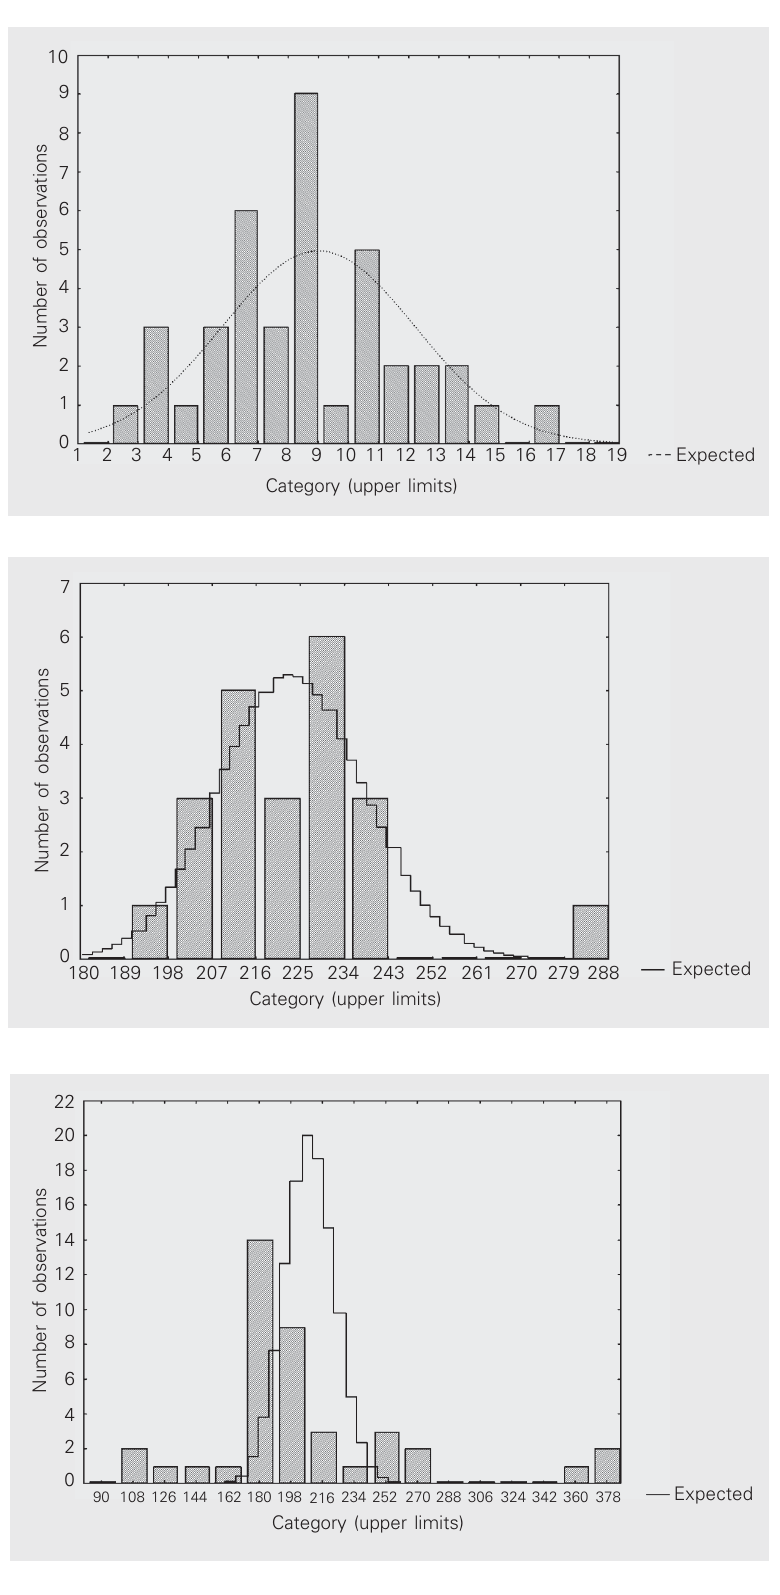
Figure 2. Distribution of baseline micronuclei among individuals aged on average 36.8 years (Kolmogorov- Smirnof test, d = 0.15, nonsignificant).